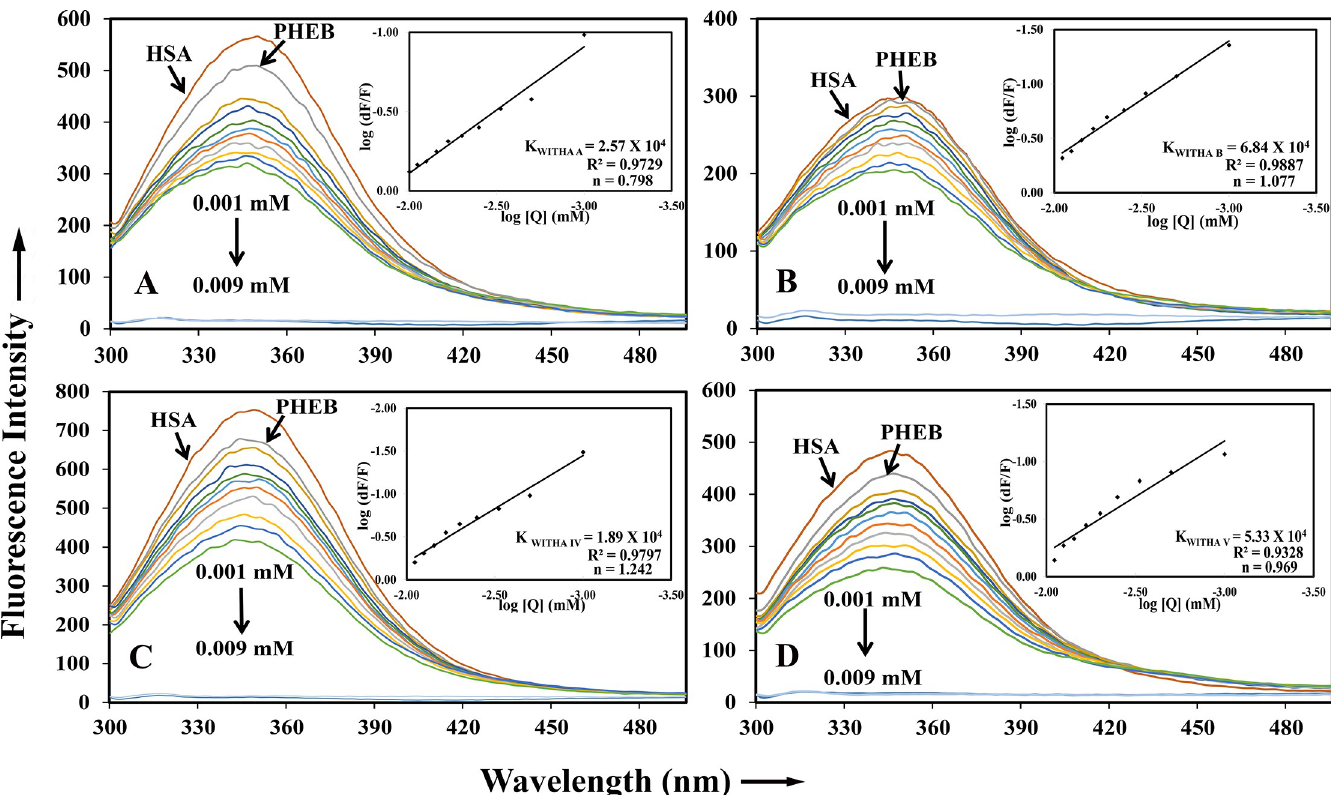
Fig 3. Site displacement studies using site-specific markers; Phenylbutazone (PHEB) was used as marker for HSA domain IIA (Sudlow site I). Fluorescence spectroscopic studies performed using HSA and Phenylbutazone at equal concentrations (1 μ M) and drugs with increasing concentrations (1 μ M ~ 9 μ M) (A) HSA-PHEB-withanolide A (B) HSA-PHEB-withanolide B (C) HSA-PHEB-withanoside IV and (D) HSA-PHEB-withanoside V.